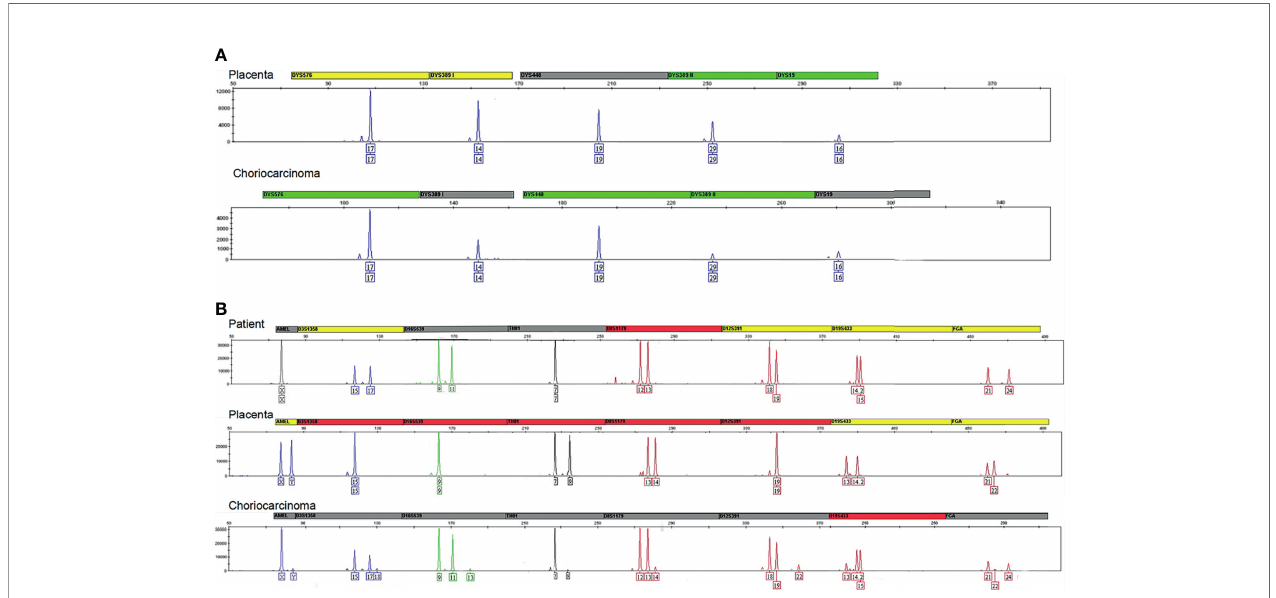
FIGURE 3 | (A) Results for the different markers located on the chromosome Y. All markers included DYS576, DYS389I/II, DYS448, and DYS19 indicated the chromosome Y in the placenta and choriocarcinoma originated from one paternal genotype. (B) The markers D3S1358, D16S539, TH01, D8S1179, D12S391, D19S433, FGA indicated autosomal STR of choriocarcinoma was different from that of the placenta tissue.